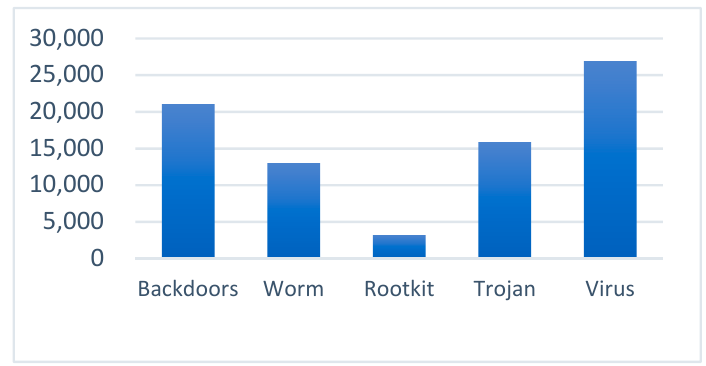
Figure 12. Type distribution of malware samples in a classification dataset.